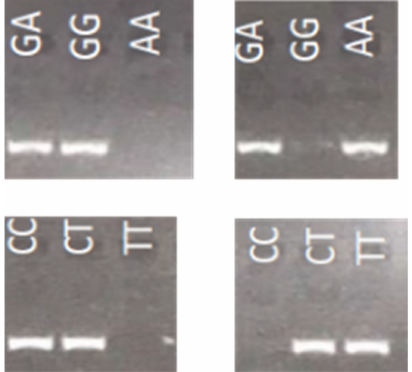
Figure 1. Allele-specific PCR for CYP2C19 alleles. Illustrative example of genotypes obtained by modification of allele-specific PCR through destabilizing mismatches, distinguishing 3 possible genotypes of CYP2C19 polymorphisms whose minor alleles define variant *2 ( upper panels ) and *17 ( lower panel ) with decreased and increased enzyme activity, respectively. ( Left panels ), PCR specific for major alleles; ( Right panel ), PCR specific for minor alleles, genotypes are indicated at the top of the panels. Denaturation, annealing, and elongation steps of PCR amplification are 30 s in duration each and were performed at 94, 60, and 72 ◦ C, respectively, for a total of 35 cycles. The PCR product was visualized by electrophoresis on a 2% agarose gel. Table 5. SNPs and their corresponding oligonucleotide sequences. Destabilizing mismatches and allele-specific nucleotides (major/minor allele) are marked in bold and